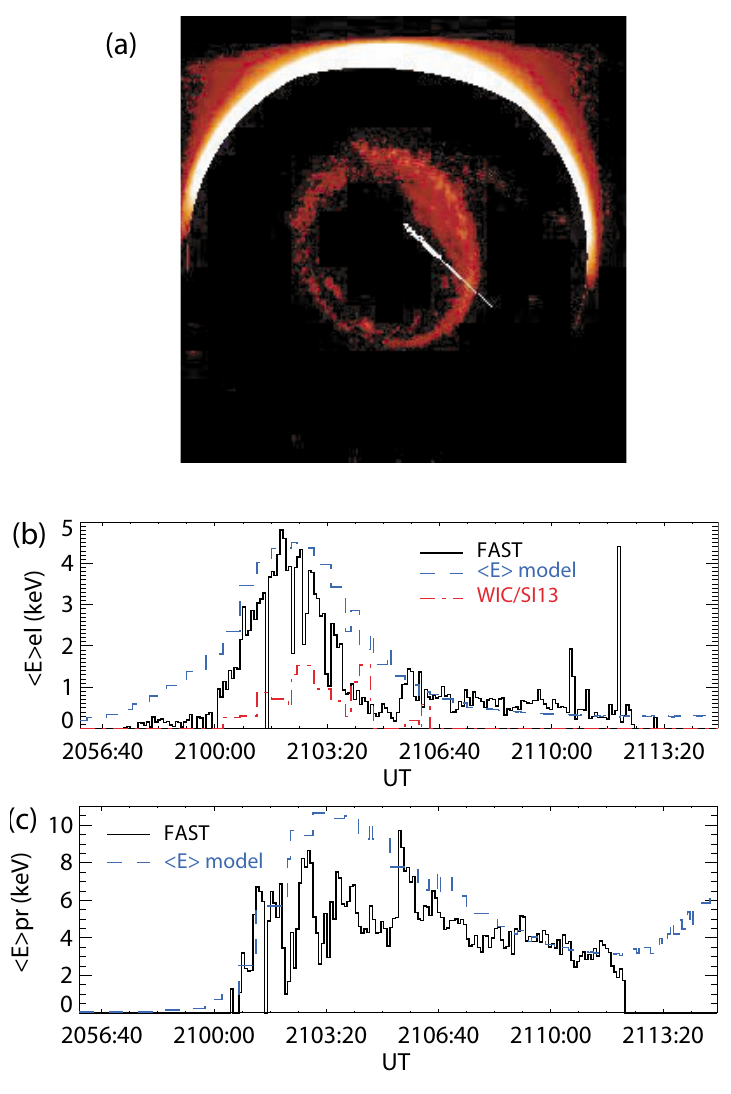
Fig. 5. Comparison between the particle precipitation characteristics evaluated from the FUV data and measured by the FAST satellite for 23 December 2000. (a) The mapped position of the FAST satellite is drawn on the WIC image. (b) The electron mean energy from the Hardy et al. (1985) empirical model (blue curve) is compared with mean energy in situ measurement (black curve) and with mean energy evaluated from the ratio between WIC and SI13 images (red curve). (c) The proton mean energy from Hardy et al. (1991) (blue curve) is compared with the FAST proton mean energy (black